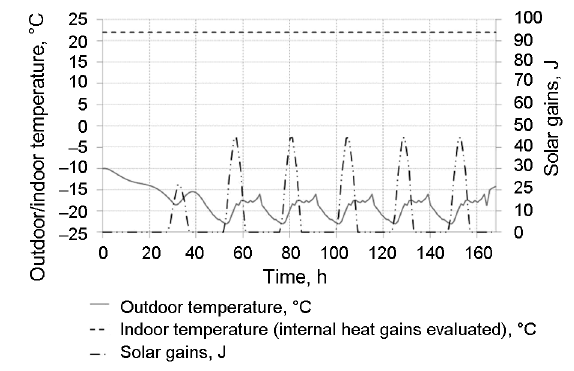
Fig. 5. Dependence of indoor temperature on the peak power of heating system. Period: theoretically framed period, Fig. 4; power: 4.74 kW